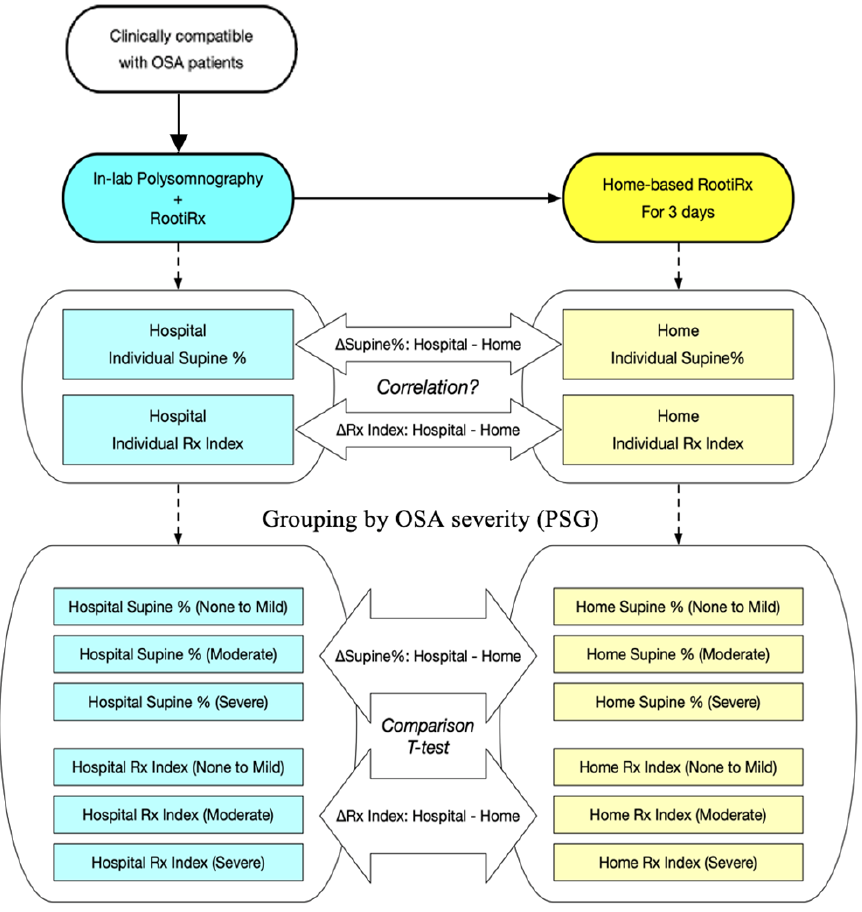
Figure 1. Study framework. Abbreviations: OSA, obstructive sleep apnoea; PSG, polysomnography; Rx index, combination of the cyclic variation of heart rate index and the chest effort index; ∆Supine%, the variations in the supine percentage; ∆Rx index, the variations in Rx index.